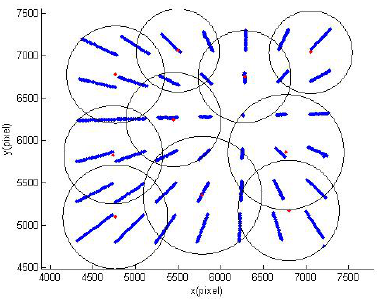
Figure 7. The initial partition of unity .